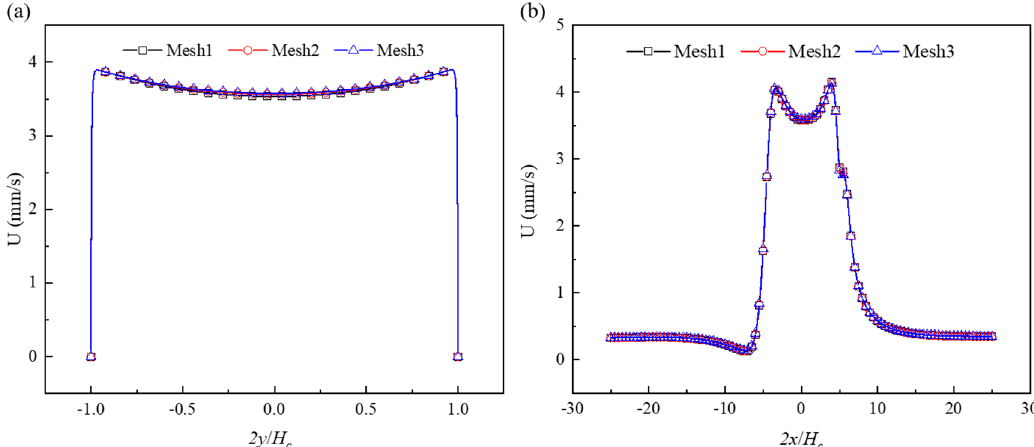
Figure A3. Spatial distribution of velocity magnitudes at t = 1.78 s . ( a ) Velocity magnitudes profile at x = 0. ( b ) Velocity magnitudes profile at y = 0.